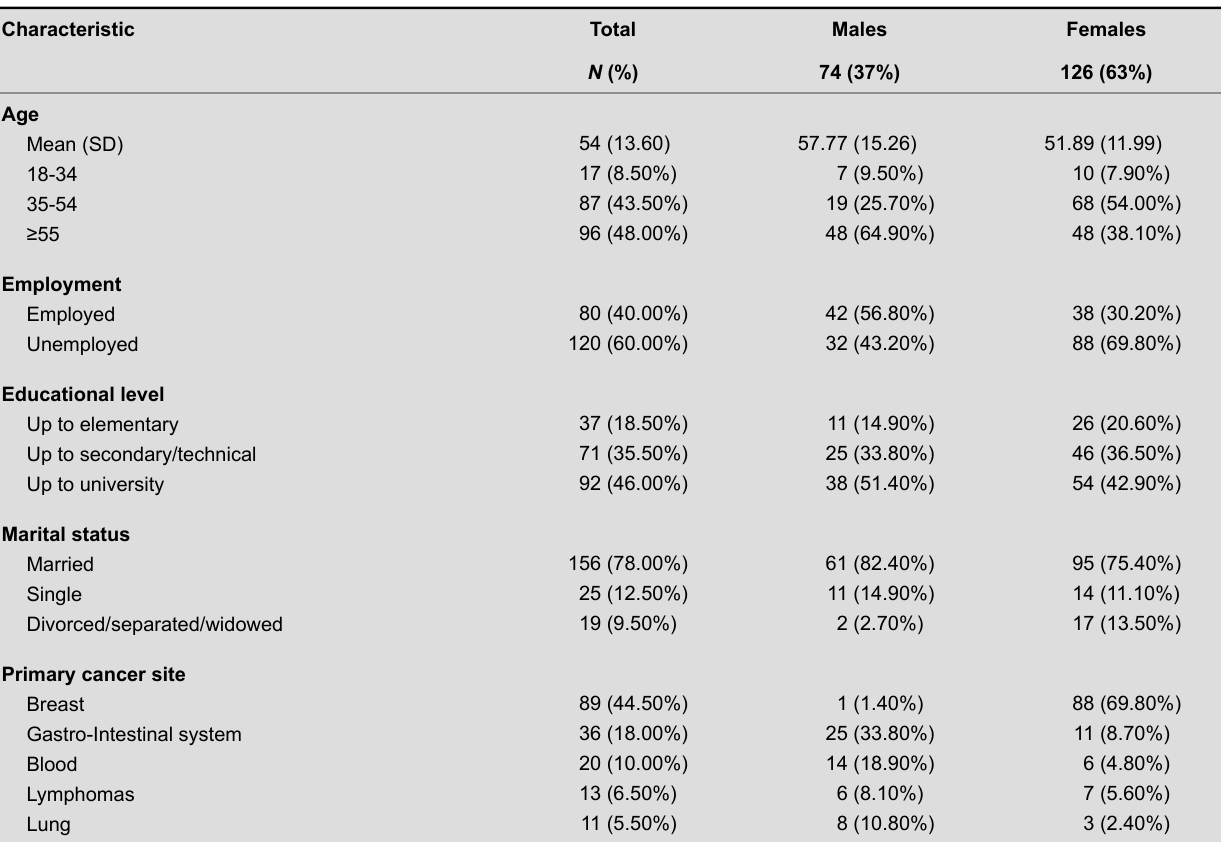
Characteristics of Participants (N = 200)